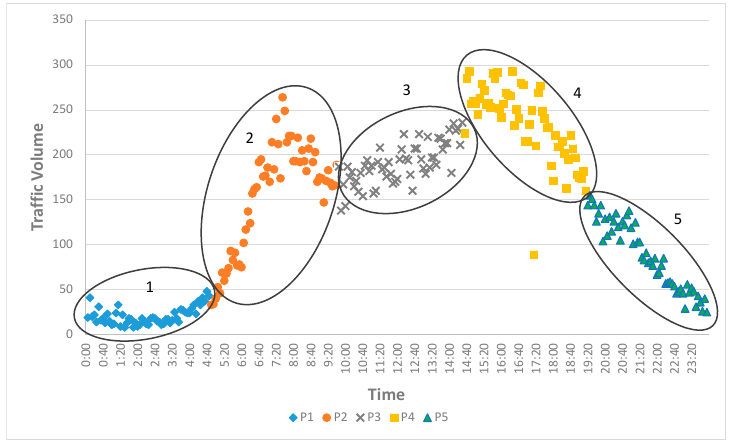
Figure 6. The five identified traffic phases.